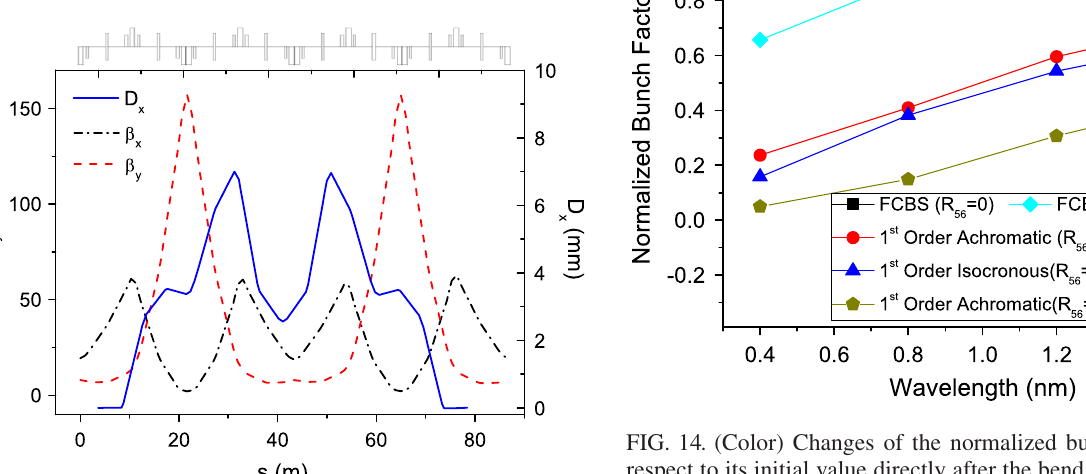
FIG. 13. (Color) Beam optical functions for FCBS.